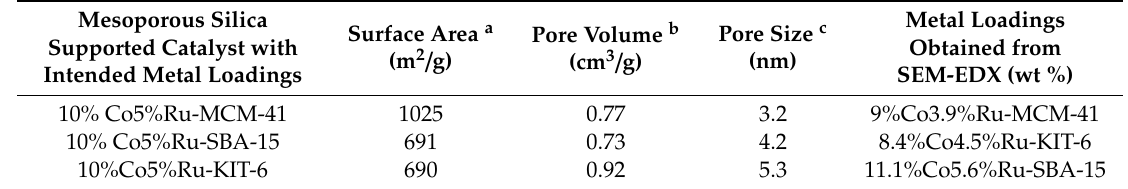
Table 1. Brunner–Emmett–Teller (BET) surface area, pore size, pore volume and EDX metal loadings of synthesized